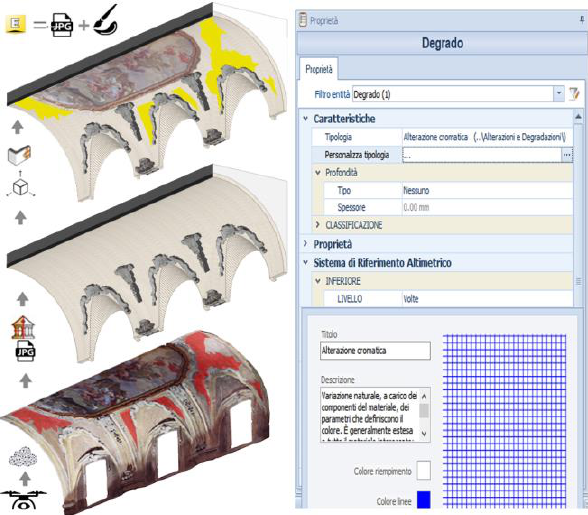
Figure 6 . Parametric H-BIM objects: decay mapping of vaults.